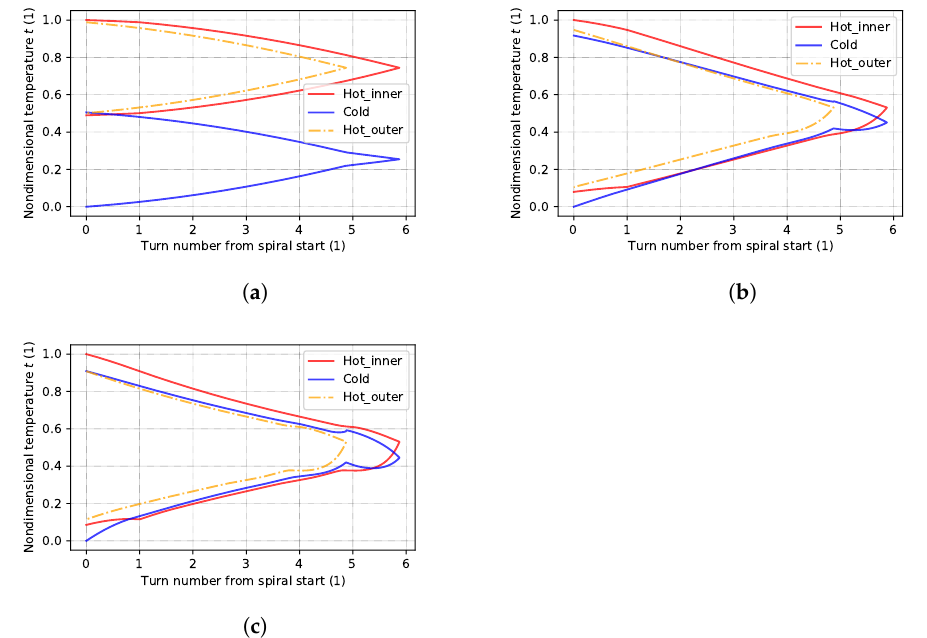
Figure 8. Predicted temperature profile in two-module SPHE with equivalent geometry to Strenger et al. [9]. ( a ) Low NTU. ( b ) Optimal NTU. ( c ) High